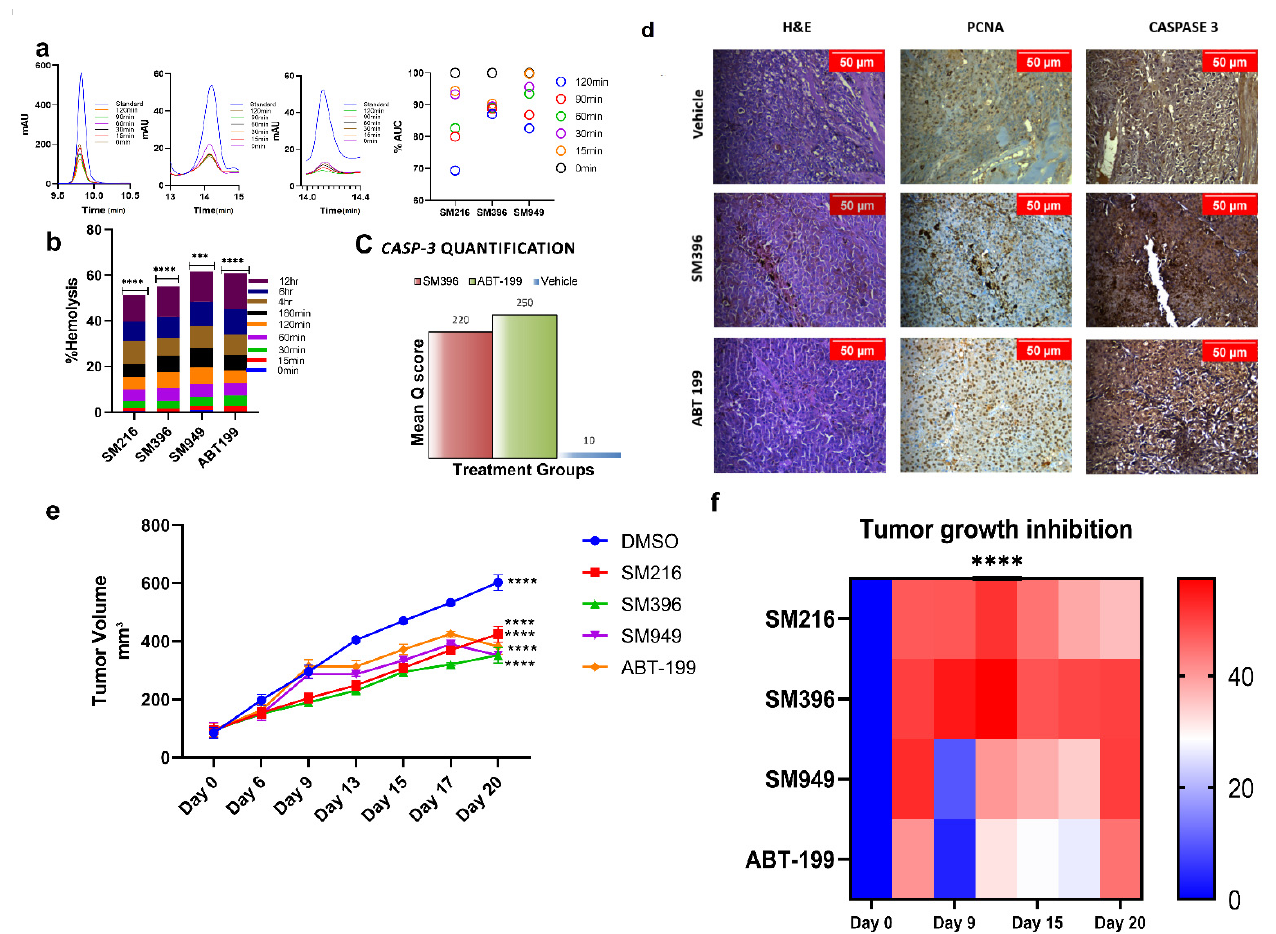
Figure 6. In vivo anti-tumor activity of SM216, SM396, and SM949 on MDA-MB-231 xenografts. ( a ) HPLC chromatograms of the compounds incubated in human plasma at different time points (0–120 min). ( b ) Bar graph showing the percentage of hemolysis (using hemolytic assay) at 0–12 h upon treatment. ( c ) Caspase-3 quantification based on mean q score (percentage of positive stained cells × Intensity of the stain) in animal tissue samples exposed to different treatments. ( d ) Photomicrographs showing the expressions of proliferation markers—PCNA and Caspase 3 staining in athymic mice mammary tissues upon treatment with vehicle control, small molecule inhibitor SM396, and positive control ABT-199 at 20X magnification. A decrease in the expression of proliferation markers and an increase in Caspase 3 expression was observed upon treatment with SM396. ( e ) Growth kinetics depicting the anti-tumor activities of the compounds and representative images of excised tumor xenografts at the end of the study. ( f ) Heat map showing the tumor growth inhibition (TGI max ). The stars indicate the p -value significance of the two-way ANOVA performed with control (ABT-199) samples. (Drug concentrations used SM216: 1.866 μ M, SM396: 2.995 nM, and SM949: 0.1875 μ M). *** = p ≤ 0.001, **** = p ≤ 0.0001